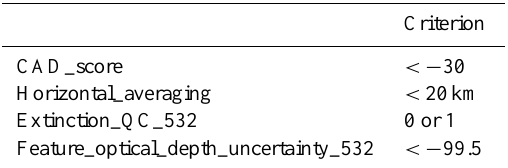
Table 1. Quality control metrics used for screening the CALIOP aerosol layer